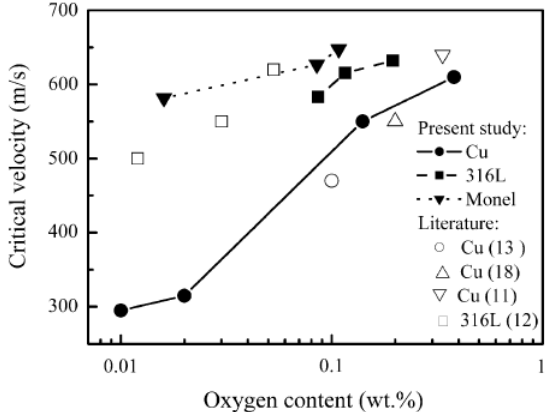
Figure 10: Effect of oxygen content on the critical velocity of different spray materials